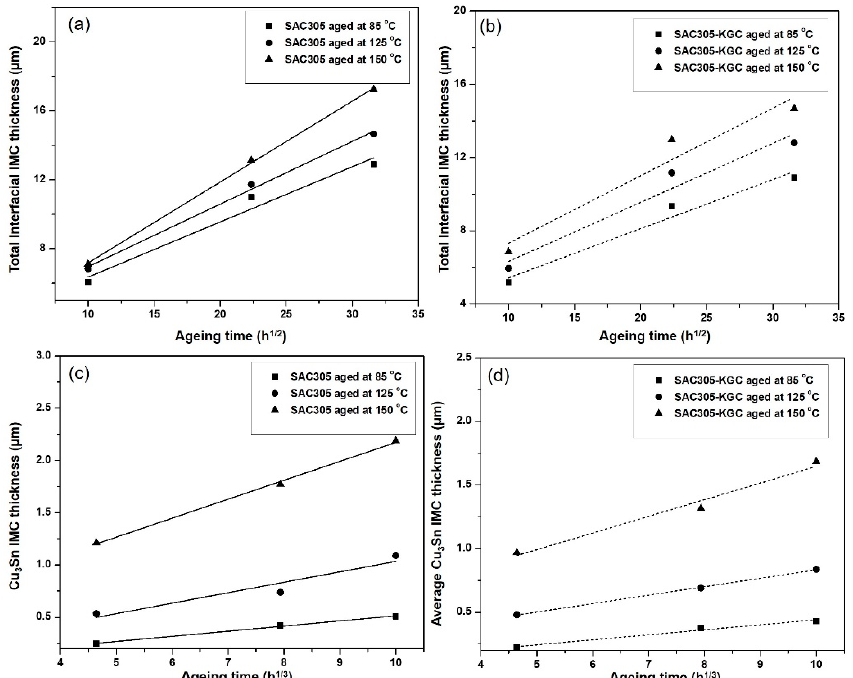
Figure 13. Time exponent of Cu 6 Sn 5 for ( a ) non-reinforced SAC305, ( b ) SAC305-KGC composite